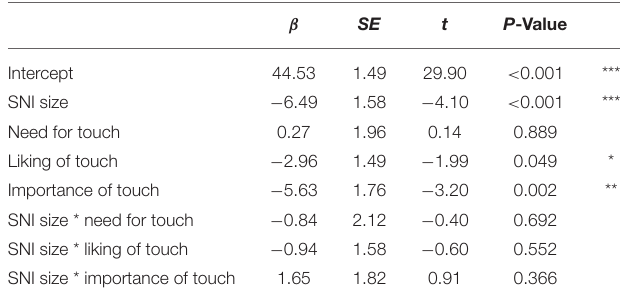
TABLE 3 | Prediction of loneliness (ULS-R) by social network size and appraisal of social touch.